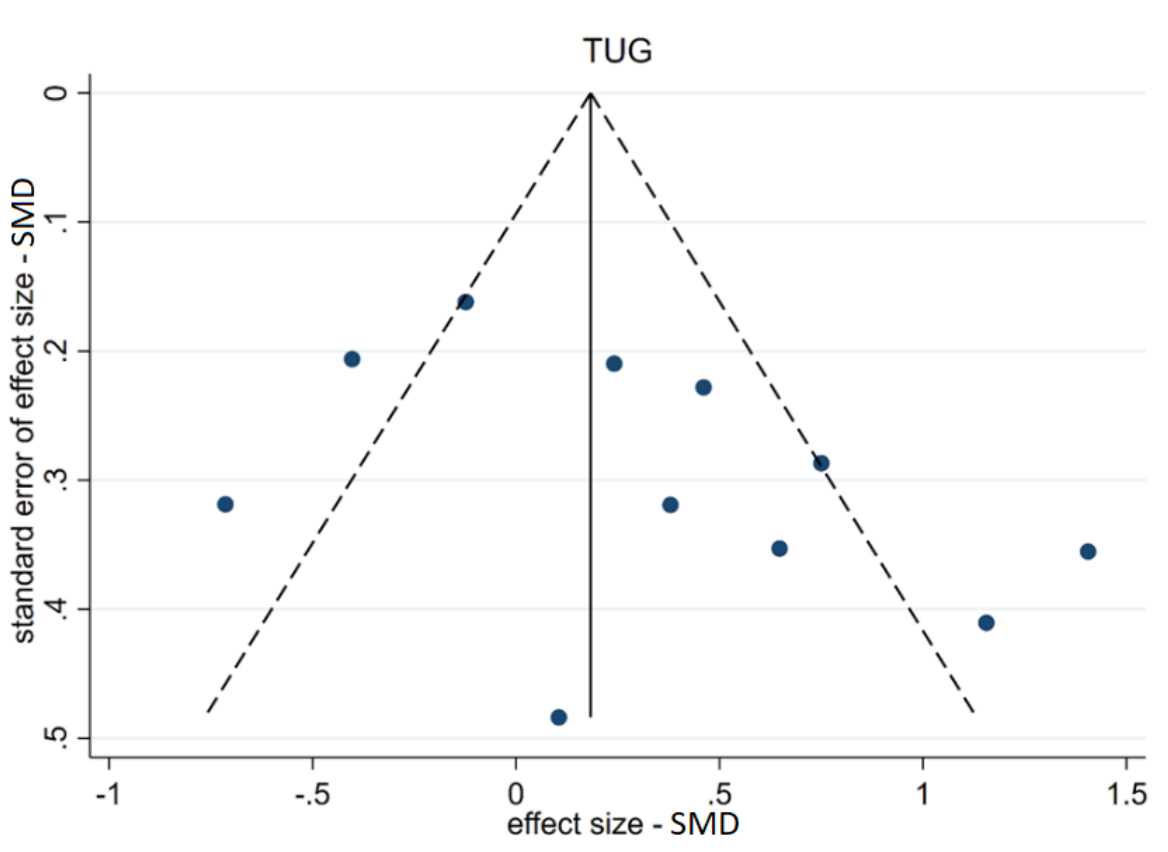
Figure 5. Funnel plot for